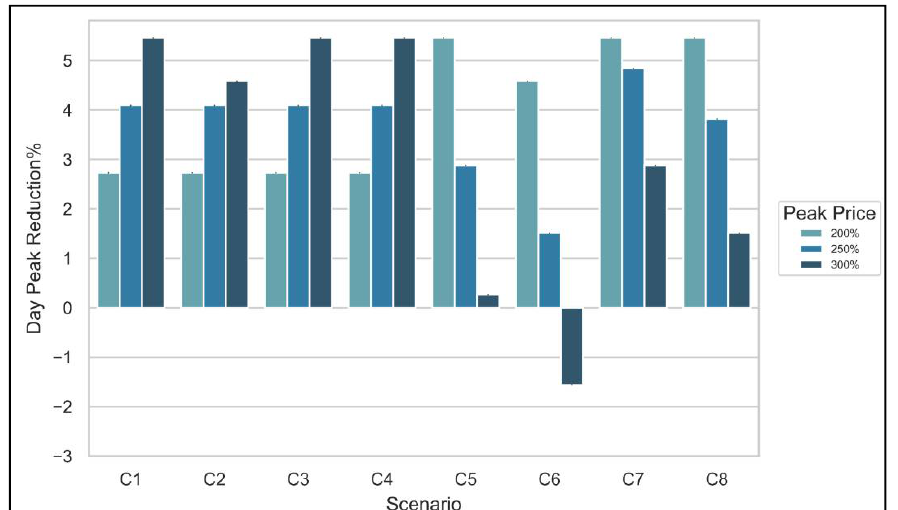
Figure 20. Day peak demand reduction percentage.